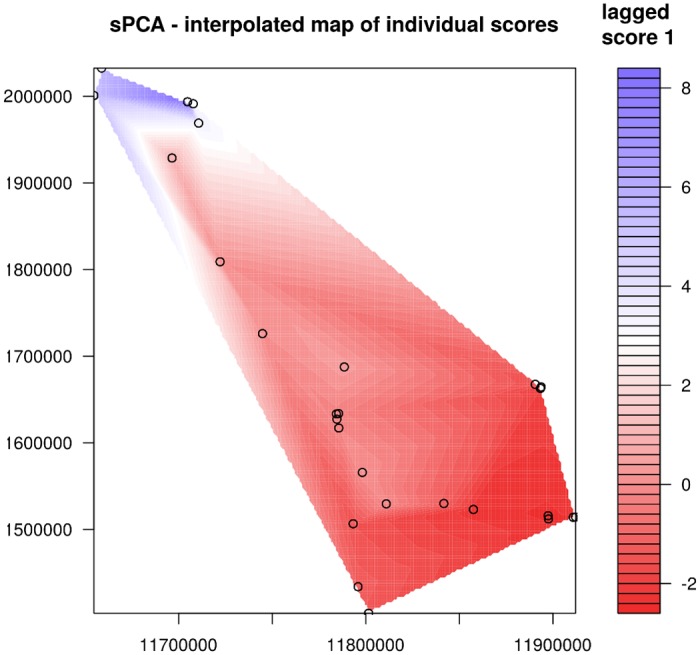
Interpolation map for Neotricula γ-aperta.The map was produced by interpolation of lagged scores of the principal components from the sPCA.